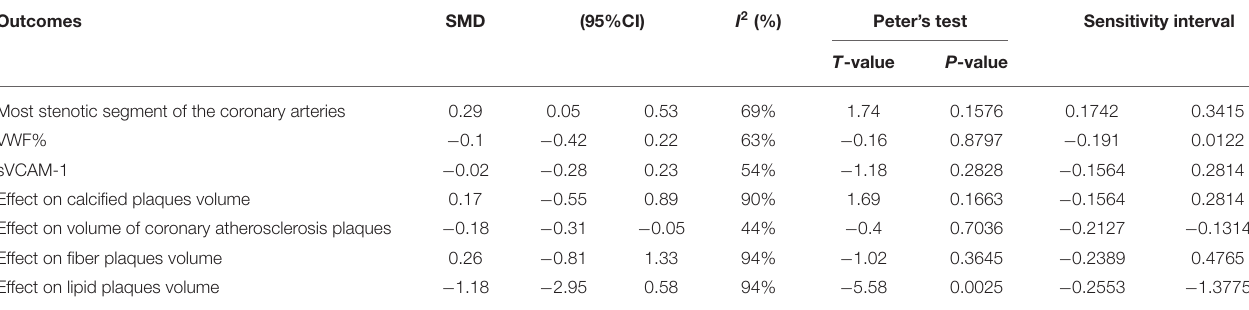
TABLE 2 | Summary of